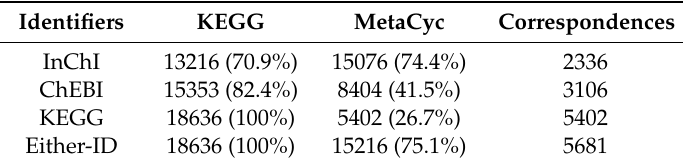
Table 2. Correspondences between KEGG and MetaCyc